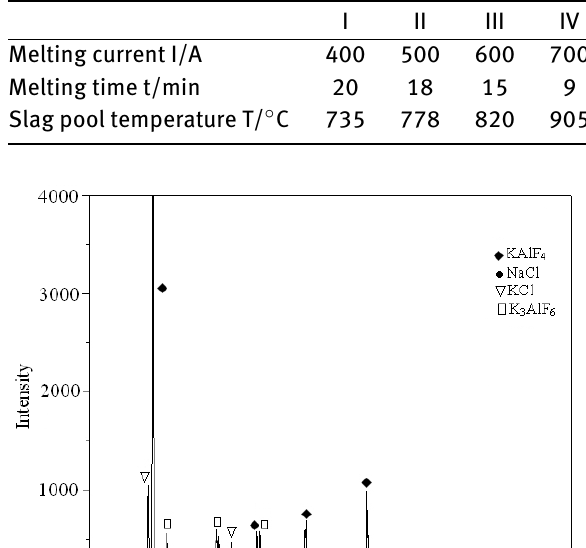
Figure 5: Dimension of the tensile specimen (in mm).